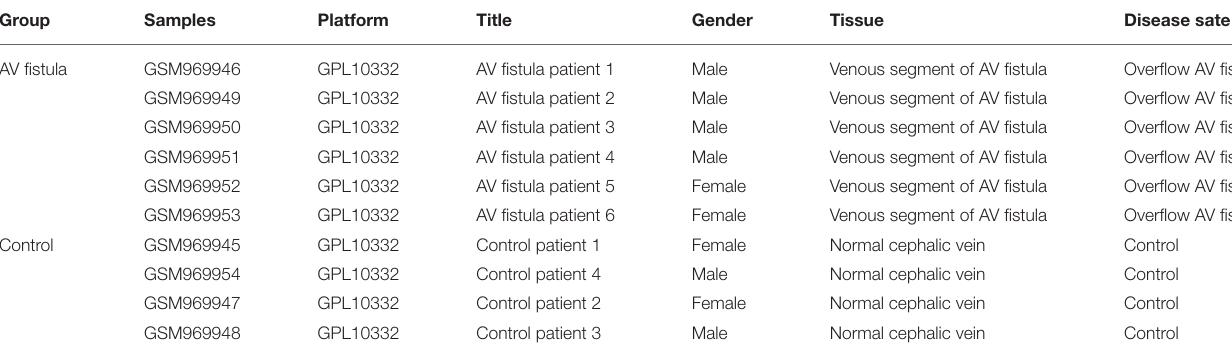
TABLE 1 | Information of samples in GSE39488 from the Gene Expression Omnibus (GEO) database. Group Samples Platform Gender Tissue Disease